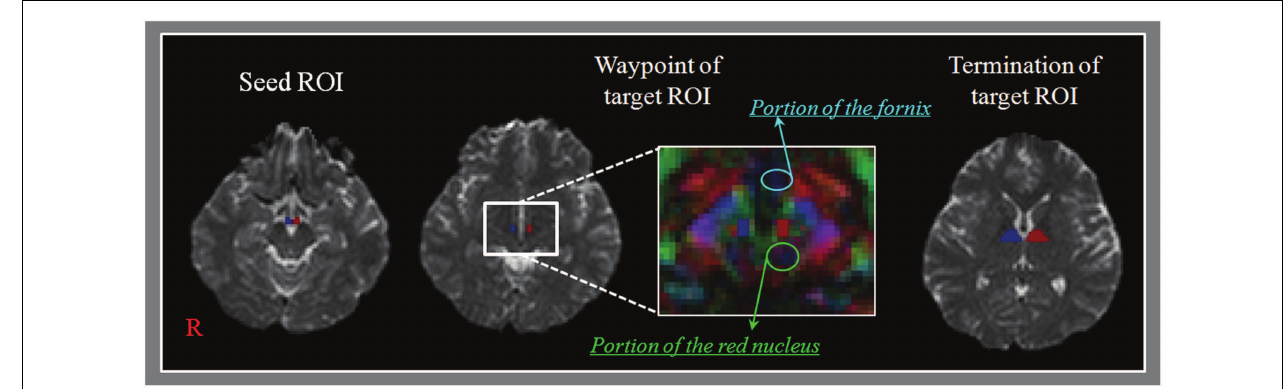
the portion of the fornix and the red nucleus in the anteroposterior direction) at about the bicommissural level on the color map.The termination of target ROI is given at the portion of anterior thalamus on the b0